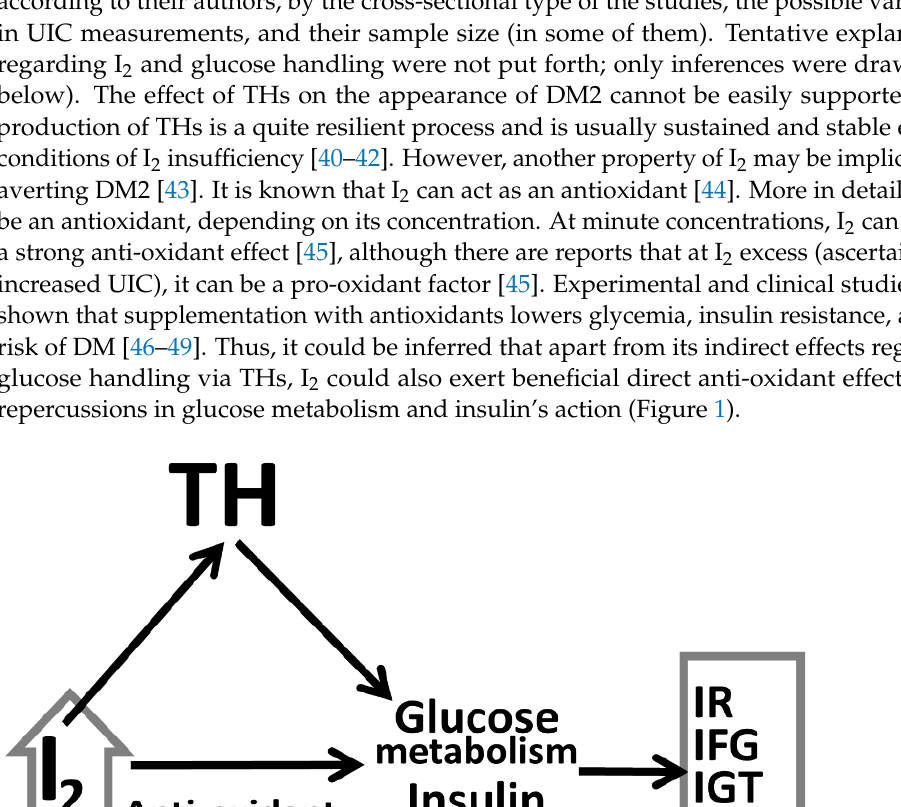
are via the synthesis and the action of thyroid hormones (TH), direct effects could be postulated via